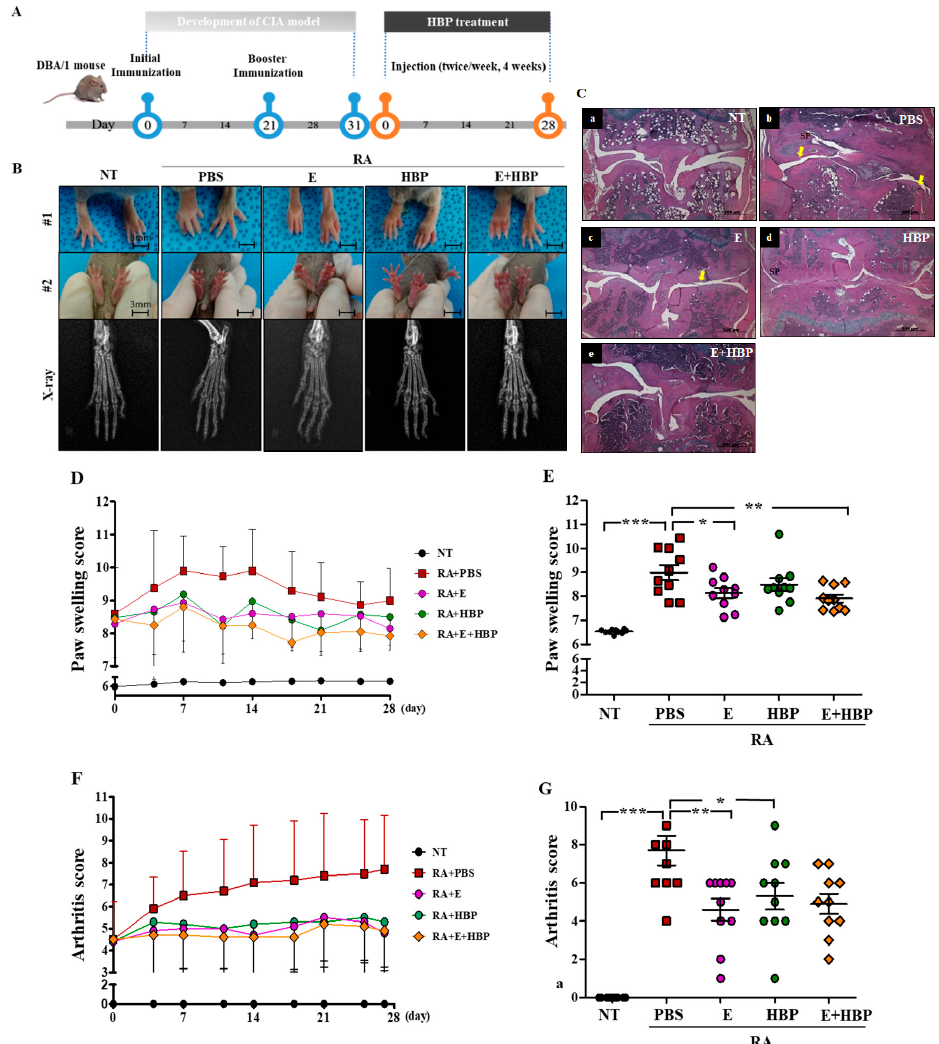
Figure 6. Development of a collagen-induced arthritis (CIA) mouse model and its application in examining the anti-rheumatic activity of HBP. ( A ) Schematic illustration of the induction of rheumatoid arthritis (RA) with collagen injection and HBP treatment. ( B ) Foot and x-ray images of all experimental groups are presented. ( C ) H&E staining of all experimental groups (SP; synovial proliferation, Yellow arrow; Pannus formation). ( D , E ) Changes in paw swelling scores over the entire experimental period. Results on day 28 from all experimental groups are presented in the bar graph ( n = 10 per group). ( F , G ) Changes in arthritis scores throughout the entire experimental period ( F ). Results on day 28 from all experimental groups are presented in the bar graph ( G ). Statistical significance between groups was analyzed using the Student’s t -test. The level of significance is represented as * p < 0.05, ** p < 0.01, or *** p <